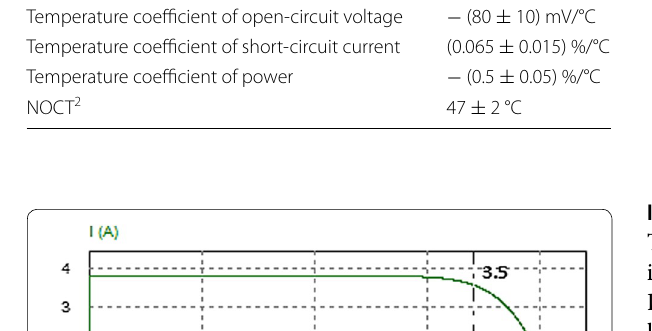
Fig. 4 DC–DC boost